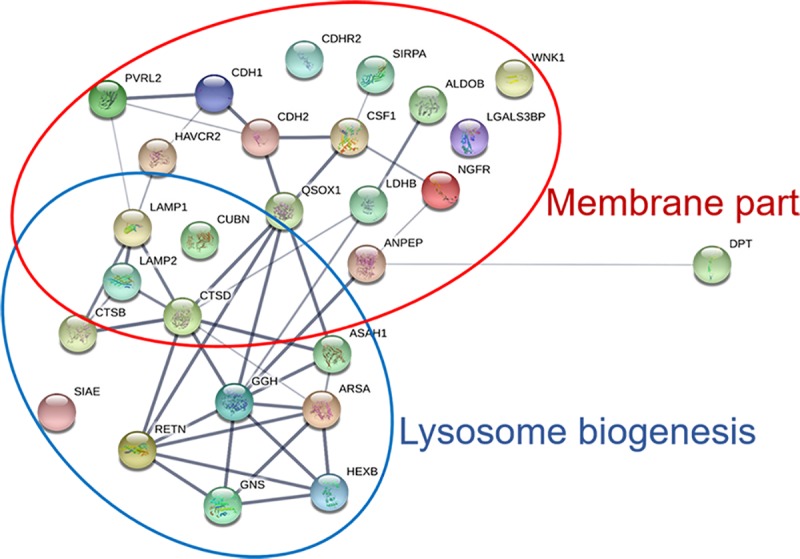
The protein interaction network analysis of 27 significant candidate proteins using the STRING database (http://string-db.org).A; two main cellular component pathways were identified in this study: lysosome biogenesis (blue circle) and membrane part (red circle). Each node lists the gene name of the candidate according to protein ID from Table 2. The different intensity of lines represents the protein association of confidence.